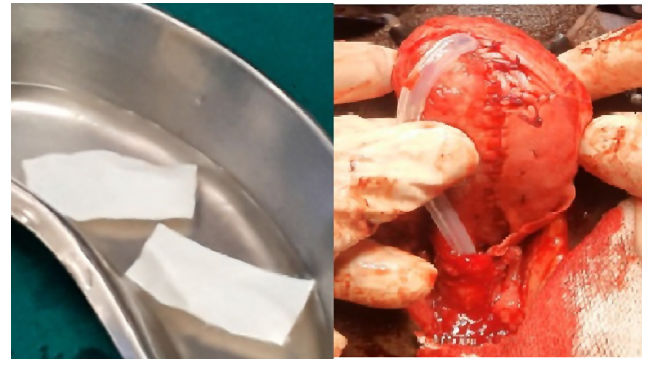
Figure 1. Acellular tissue engineered pericardial patch in normal saline (cut in two pieces) with quilted acellular tissue engineered pericardial patch with silicon Foley’s catheter in